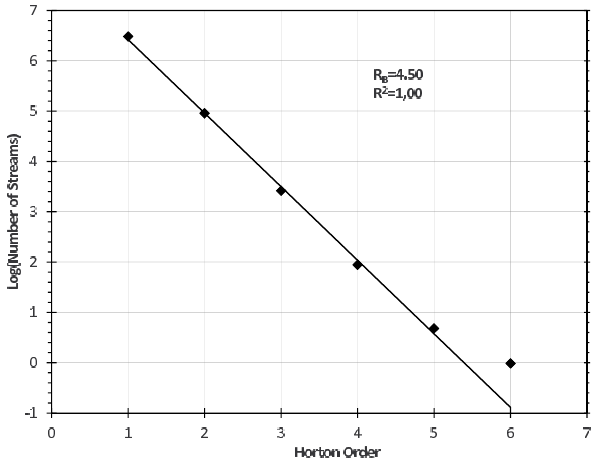
Figure 6. Horton plot for discharge (including orders 2, 3, and 4) for the Ashley River basin (McKerchar et al., 1998); results kindly provided by Mantilla